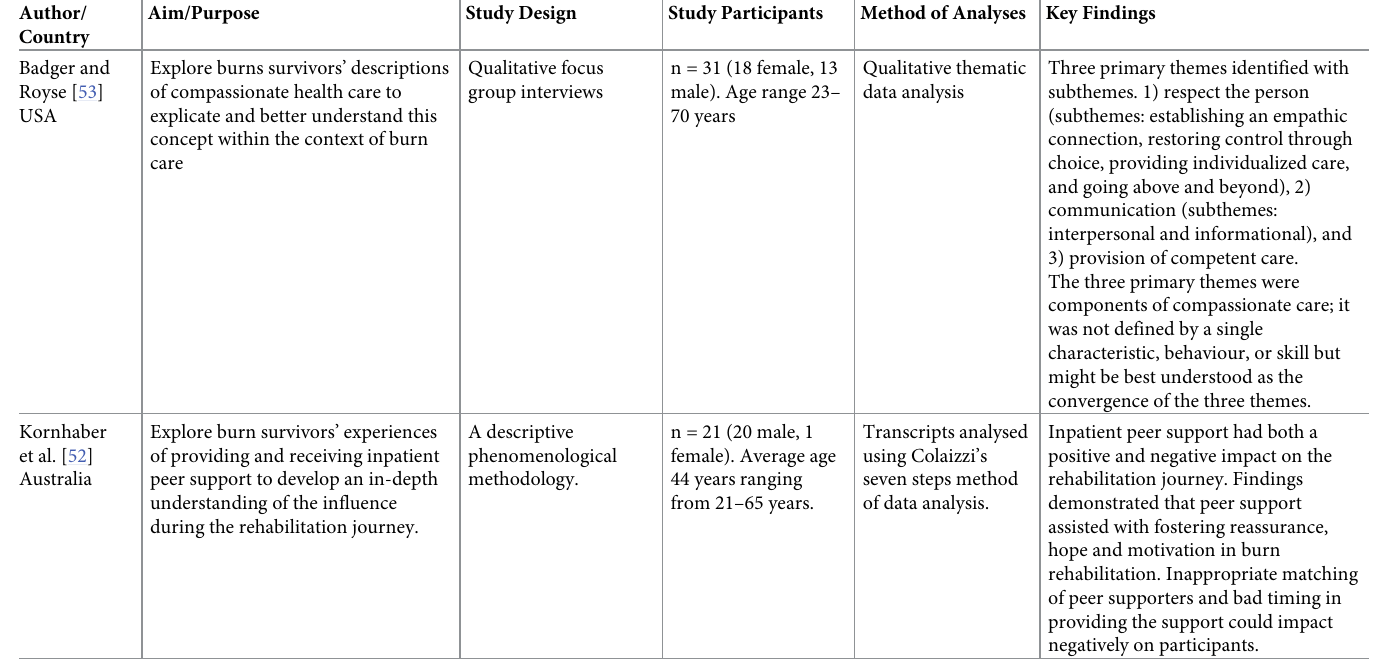
Table 3. Characteristics of the included qualitative